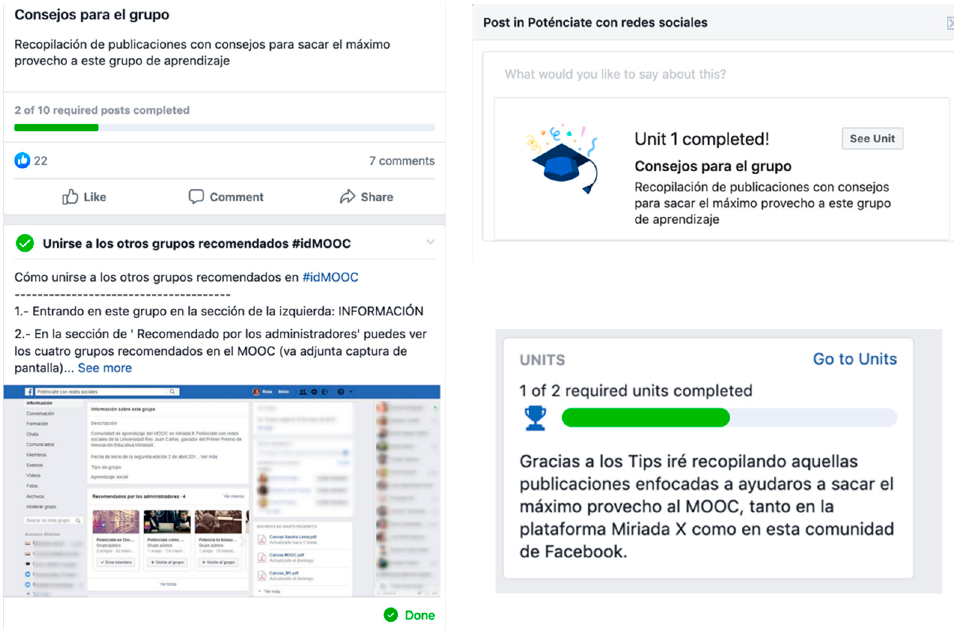
Figure 1. Screenshots of units in Facebook Groups.